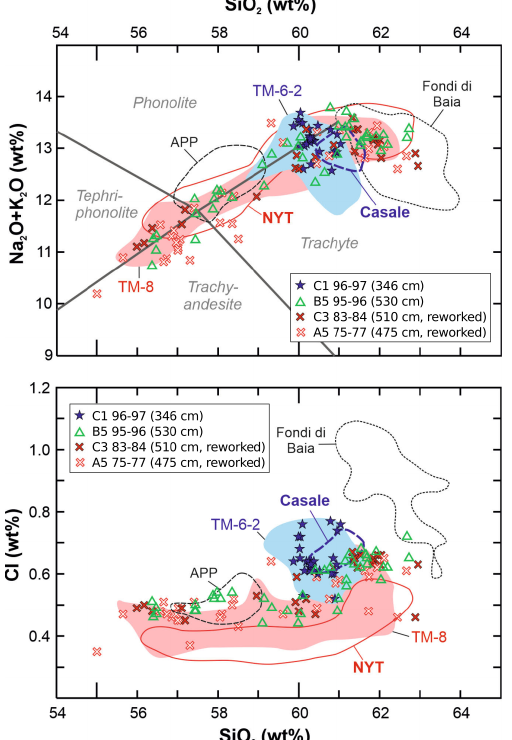
Figure 4. Bivariate plot of selected major elements (SiO 2 vs. total alkalis and SiO 2 vs. Cl) of the Matese tephra and potential proxi- mal and Monticchio tephra correlatives. Data are taken from TM- 6-2 (Monticchio, Wulf et al., 2008; this study), TM-8 (Monticchio, Tomlinson et al., 2012; this study), Casale in Fondi di Baia (proxi- mal; Smith et al., 2011), and Agnano Pomici Principali (APP) and Neapolitan Yellow Tuff (NYT, proximal; Tomlinson et al.,